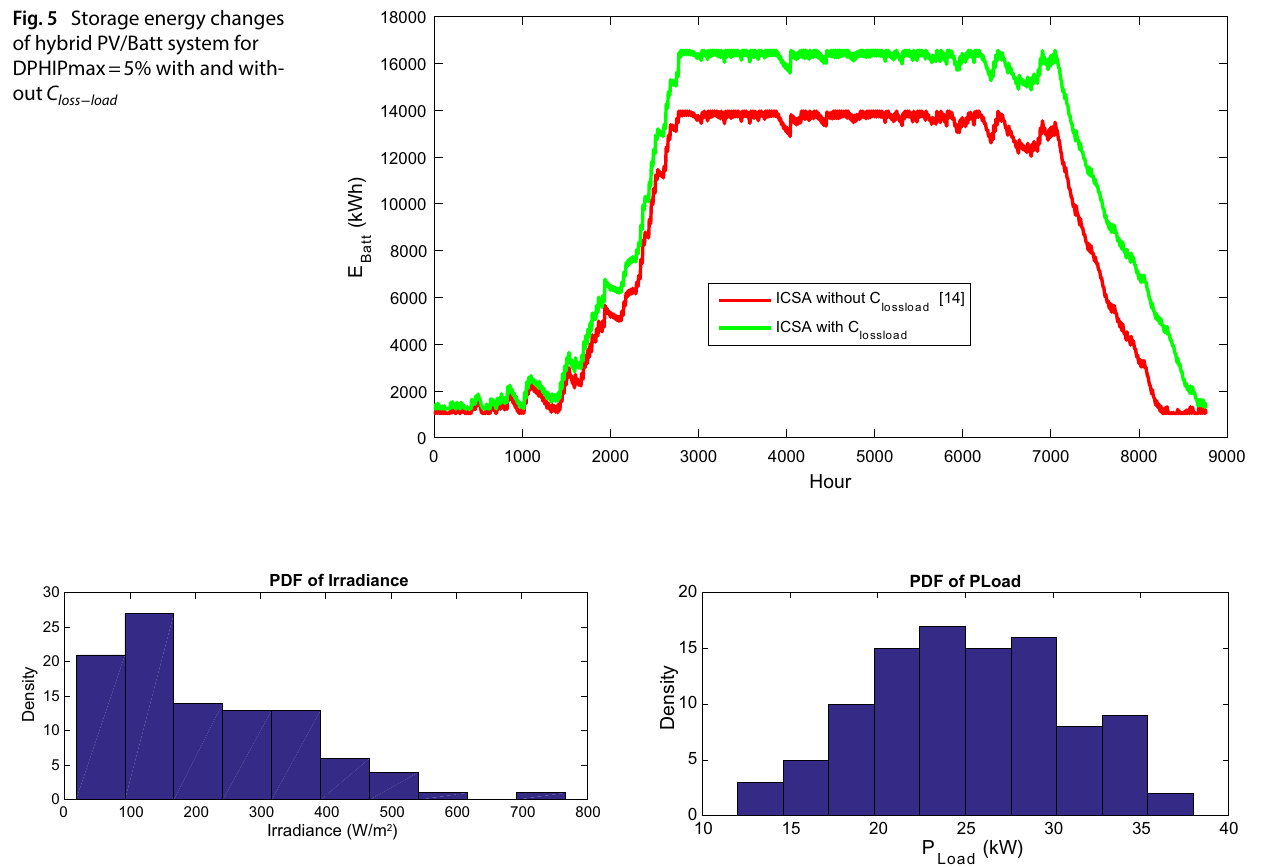
Fig. 6 Irradiance probability distribution function